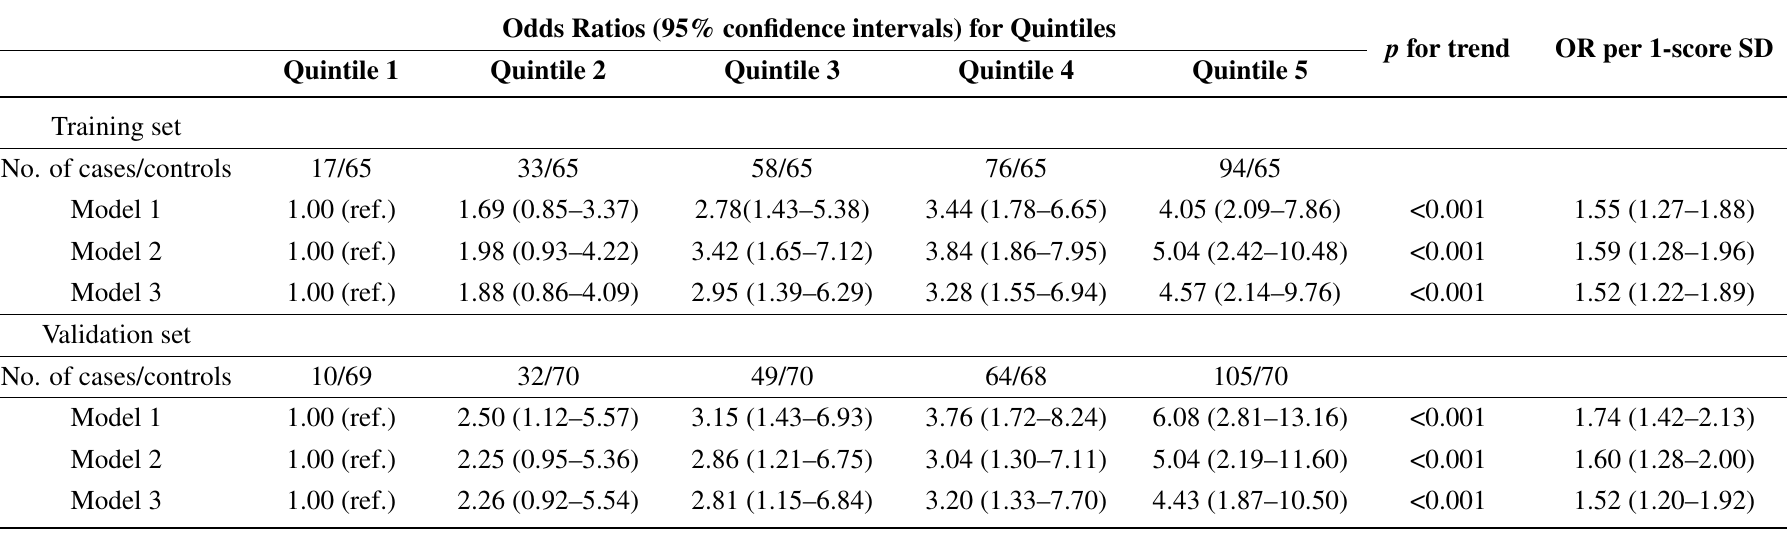
Table 4. Odds Ratios (OR) and 95% confidence intervals for type 2 diabetes by quintiles and per 1 SD of the dietary pattern score. Odds Ratios (95% confidence intervals) for Quintiles p for trend OR per 1-score SD Quintile 1 Quintile 2 Quintile 3 Quintile 4 Quintile